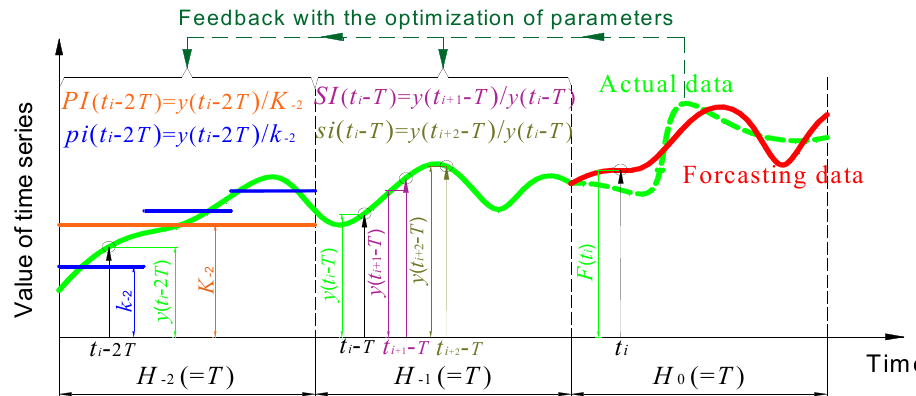
Figure 1. The schematic diagram of the period-sequential index algorithm (PSI) algorithm .